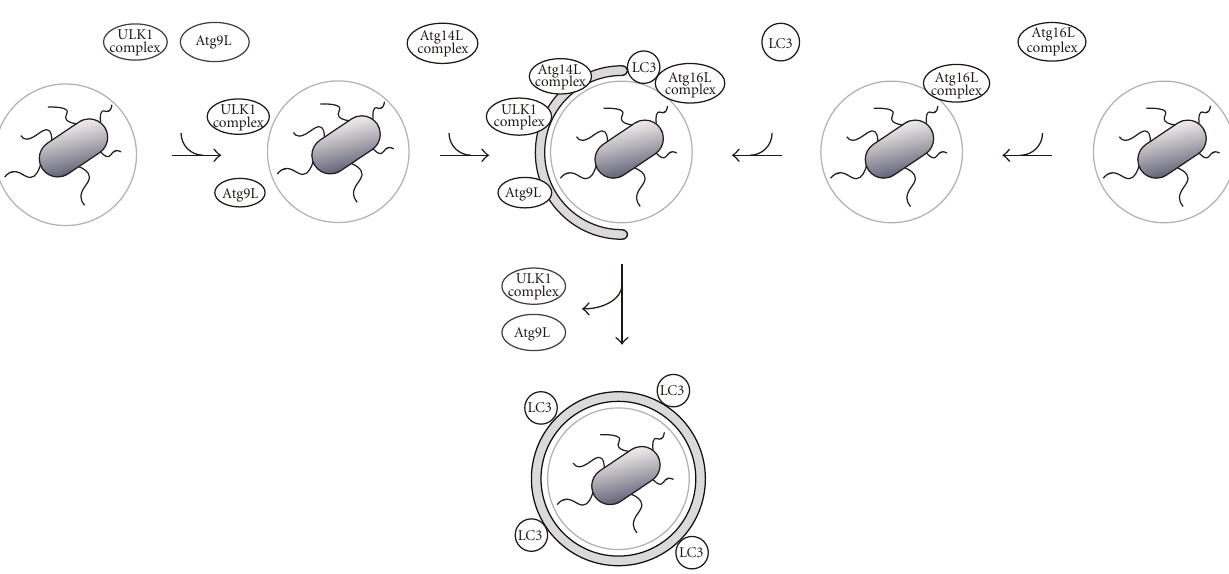
Figure 1: Schematic representation of the three-axis model for Atg recruitment in Salmonella xenophagy Salmonella enterica serovar Typhimurium is inside the SCV, but some bacterial cells are captured by the autophagic machinery. LC3 is recruited by Atg16L complex, but this recruitment is not dependent on the other factors depicted here. Even in the absence of these factors, an autophagosome-related membrane is observed. Ulk1 complex (including FIP200) and Atg9L1 recycle between the vicinity of Salmonella and the other cellular pools. Both are recruited to Salmonella independent of one another, but their detachment from Salmonella proximity is interdependent. Atg14L- containing PI3-kinase complex recruitment is dependent on both Ulk1 complex and